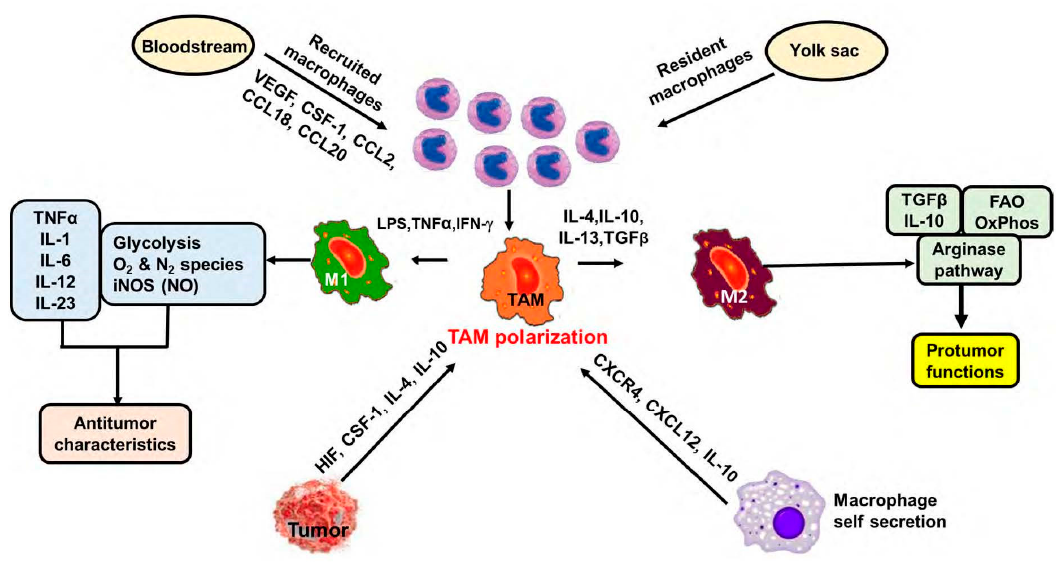
Figure 1. Macrophage Recruitment and Polarization. Monocytes from the bloodstream can be recruited to differentiate into macrophages under the influence of cytokines and growth factors such as CCL2, CCL18, CCL20, colony-stimulating factor -1 (CSF-1), and vascular endothelial growth factors (VEGFs). These recruited macrophages, along with resident macrophages, present in lung alveoli and peritoneum, epidermal Langerhans cells, Kupffer cells, and brain microglia, take part in the macrophage polarization process. Macrophages turn into either the proinflammatory M1 phenotype in the presence of LPS, TNF α , and IFN- γ or by, IL-4, IL-10 and IL-13 into the M2-polarized macrophages, which are generally known as TAMs. Tumors and macrophages present in the TME can release HIF, CSF-1, and interleukins CXCR4, CXCL12, and IL10, respectively, to stimulate the macrophage polarization process. Macrophages with M1 phenotype show antitumor characteristics while M2 type macrophages demonstrate protumor characteristics.